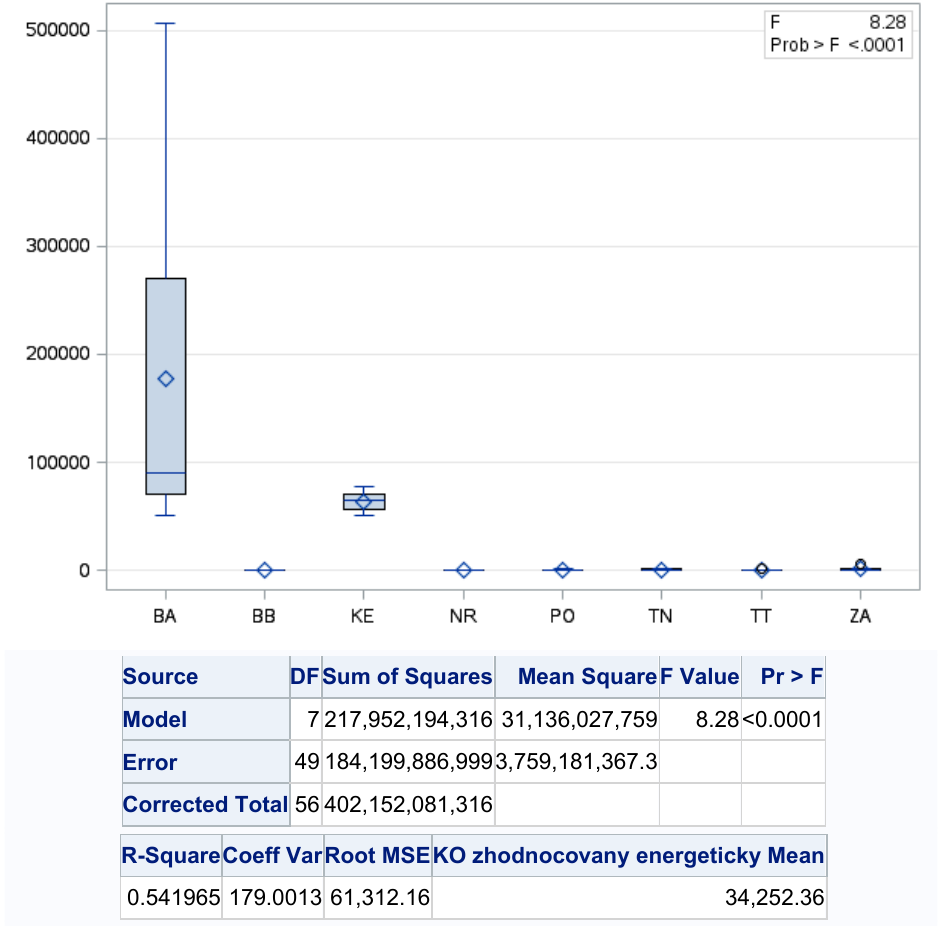
Figure 7. One-factor analysis of energy recovery of municipal waste on the regions of Slovakia. Source: Based on of data collected by Statistical Office of Slovak Republic [29].